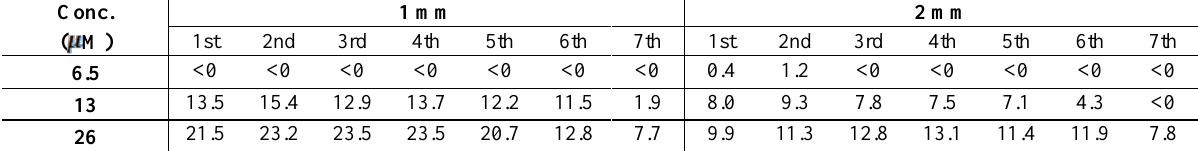
Table 1. SNR of fluorescence signal (dB) for all